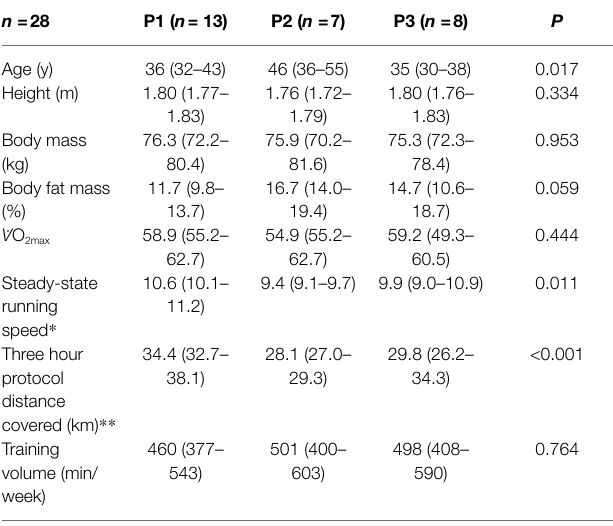
TABLE 1 | Participant